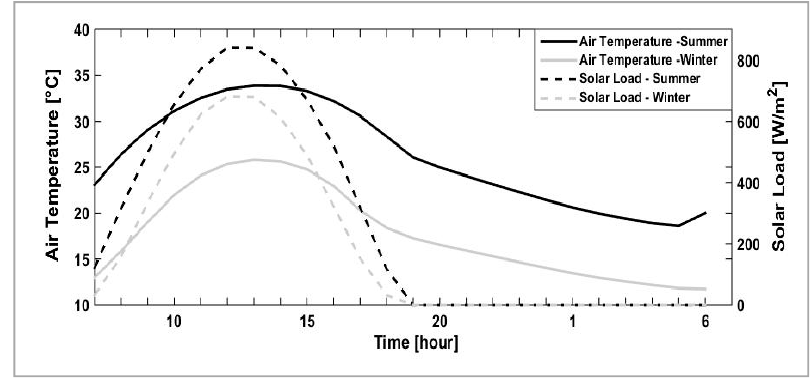
Figure 2. Daily air temperature and solar load profiles assumed for the summer and winter seasons.